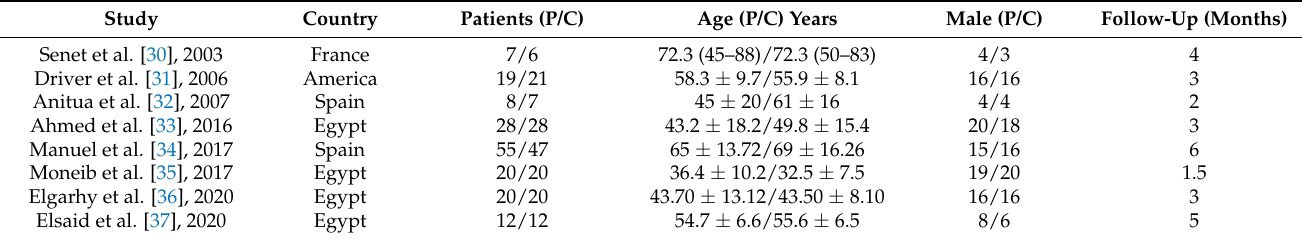
Table 1. The demographic characteristics of all investigated RCTs. P represents the PRP group. C represents the normal saline